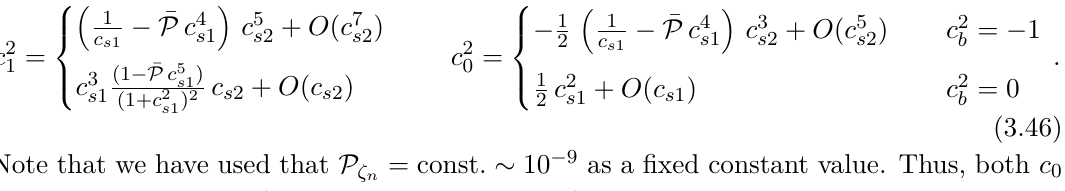
Table 1. Independent parameters and constraints for